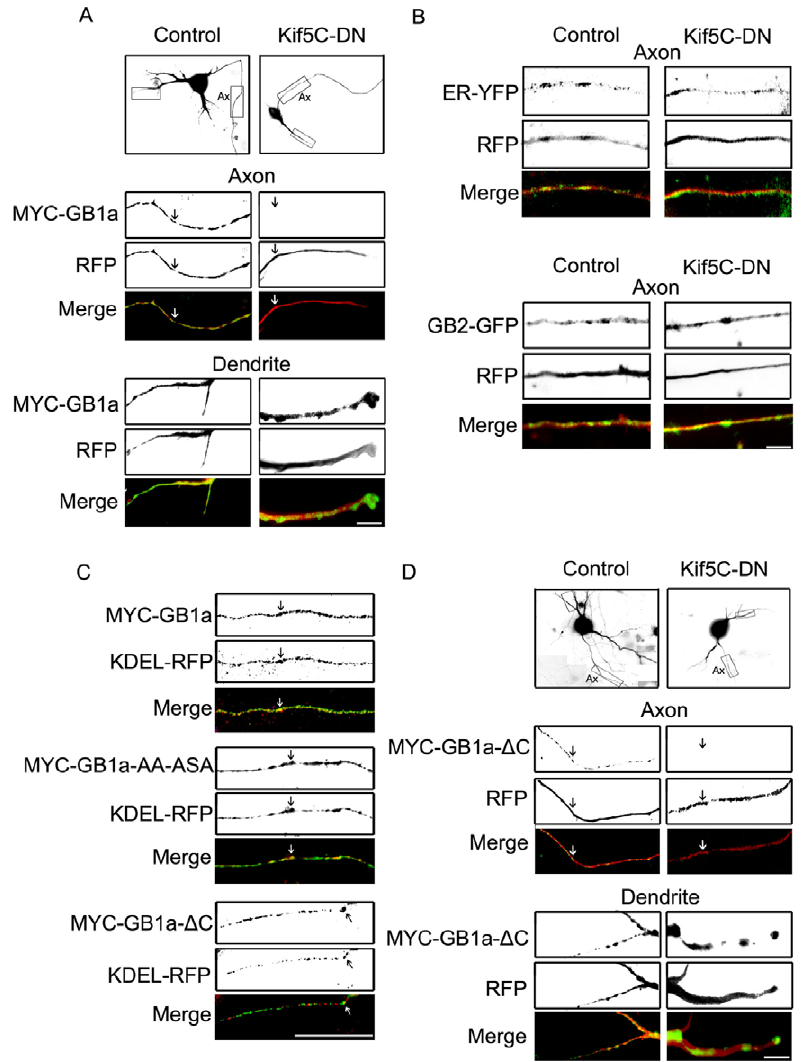
Figure 5. Axonal targeting of GABA B R1a is kinesin-1 dependent and C-terminal domain independent. ( A ) Hippocampal neurons were transfected with MYC-GABA B R1a and RFP (left, representative image of n=12 neurons) or MYC-GABA B R1a and Kif5C-RFP-DN, a dominant negative version of kinesin-1 (Kif5C-DN, right, representative image of n=13 neurons). The neuronal volume filled by RFP or Kif5C-RFP-DN is shown. Boxes in top panels correspond to regions of axons (Ax) and dendrites (unlabelled) magnified below. MYC-GABA B R1a (green) and RFP or Kif5C-RFP-DN (red). Merged images are shown on the bottom panel. Scale bar represents 40 m m. ( B ) Top panels: representative axon of hippocampal neurons transfected with pEYFP-ER (ER-YFP) and RFP or pEYFP-ER and Kif5C-RFP-DN. Markers were visualized without staining. Merged images are shown on the bottom panel (representative image of n=15 neurons). Bottom panels: representative axon of hippocampal neurons transfected with GABA B R2- EGFP (GB2-GFP) and RFP or GABA B R2-EGFP and Kif5C-RFP-DN. Markers were visualized without staining. Merged images are shown on the bottom panel (representative image of n=15 neurons). Scale bar for represents 40 m m. ( C ) Representative axons of hippocampal neurons transfected with KDEL-RFP and MYC-GABA B R1a, or MYC-GABA B R1a-AA-ASA, or MYC-GABA B R1a- D C, and processed for immunofluorescence under permeabilized conditions. MYC-GABA B R1a versions were detected with MYC antibodies (MYC-GB1a, MYC-GB1a-AA-ASA, MYC-GB1a- D C); KDEL-RFP was visualized without staining (representative images of n=20, 9 and 10 neurons respectively). Merged images are shown on the bottom panels. Scale bar represents 20 m m. ( D ) Hippocampal neurons were transfected with MYC-GABA B R1a- D C and RFP (left, representative image of n=12 neurons) or MYC-GABA B R1a- D C and Kif5C-RFP-DN (Kif5C-DN, right, representative image of n=9 neurons). The neuronal volume filled by RFP or Kif5C-RFP-DN is shown. Boxes in top panels correspond to regions of axons (Ax) and dendrites (unlabelled) magnified below. MYC-GABA B R1a- D C (green) and RFP or Kif5C-RFP-DN (red). Merged images are shown on the bottom panel. Scale bar represents 40 m m. doi:10.1371/journal.pone.0044168.g005 (Figs. 1D and 1G, right panels). According to previous reports the transgenic mice that express GABA B R1-EGFP under the control predominant axonal variant of GABA B R1 corresponds to of an endogenous promoter [10]. This experimental model GABA B R1a [7], [8]. Therefore, these data are compatible with combines the advantages of a nearly physiological scenario and ease of detection. GABA B R1 localized to the axon in control the idea that GABA B R1a is sorted and targeted to the axon at or conditions (Figs. 1D and 1G, left panel). Importantly, GABA B R1 prior to the Golgi apparatus. was still targeted to the axon in the presence of ARF1-Q71I-HA